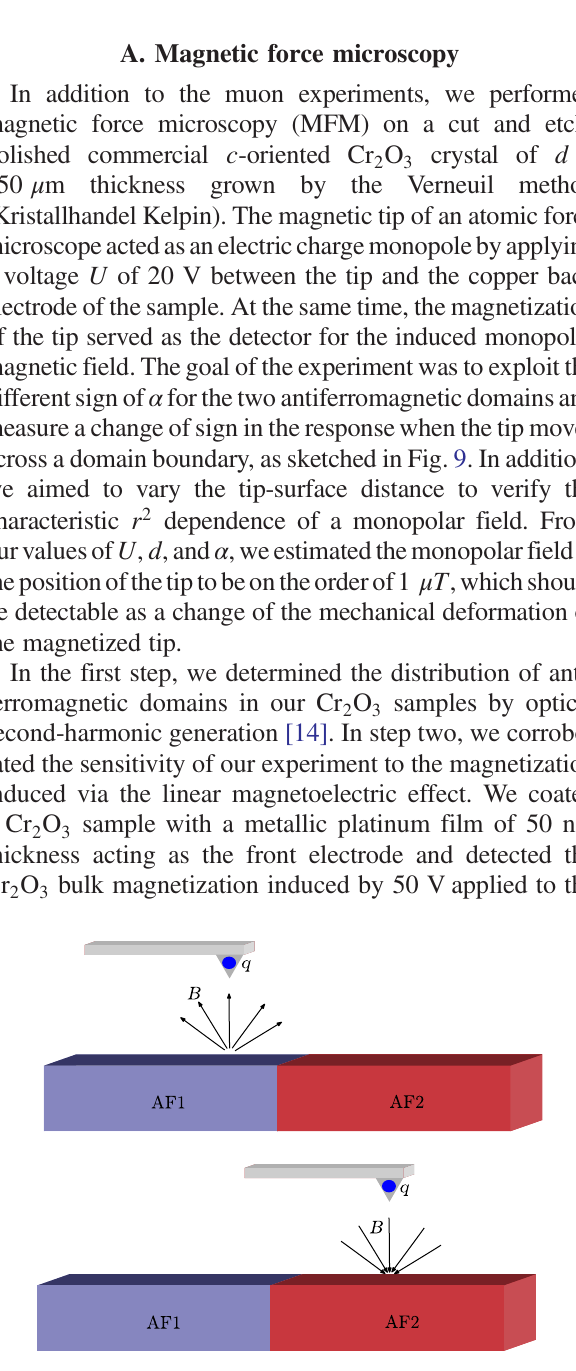
FIG. 9. Proposed technique for measuring monopolar magnetic fields. The charged MFM tip both induces the image monopole and detects its field. AF1 and AF2 indicate oppositely oriented antiferromagnetic domains, which support monopoles and asso- ciated fields of opposite